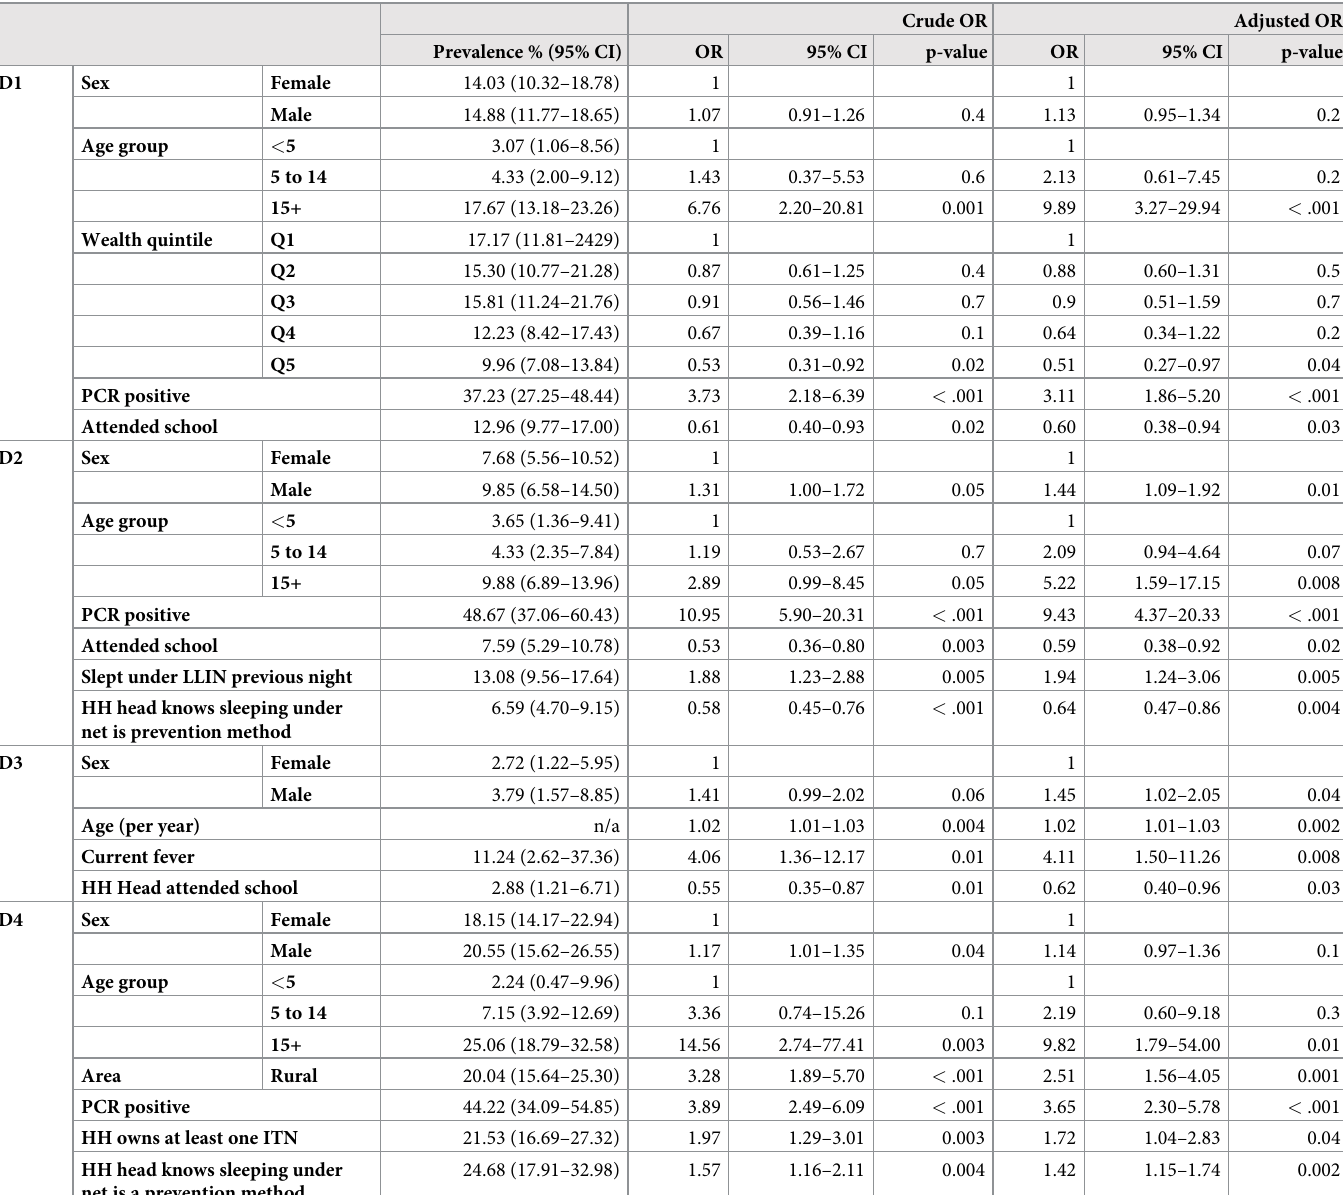
Table 5. Crude and adjusted odds ratios for P . vivax seropositivity per